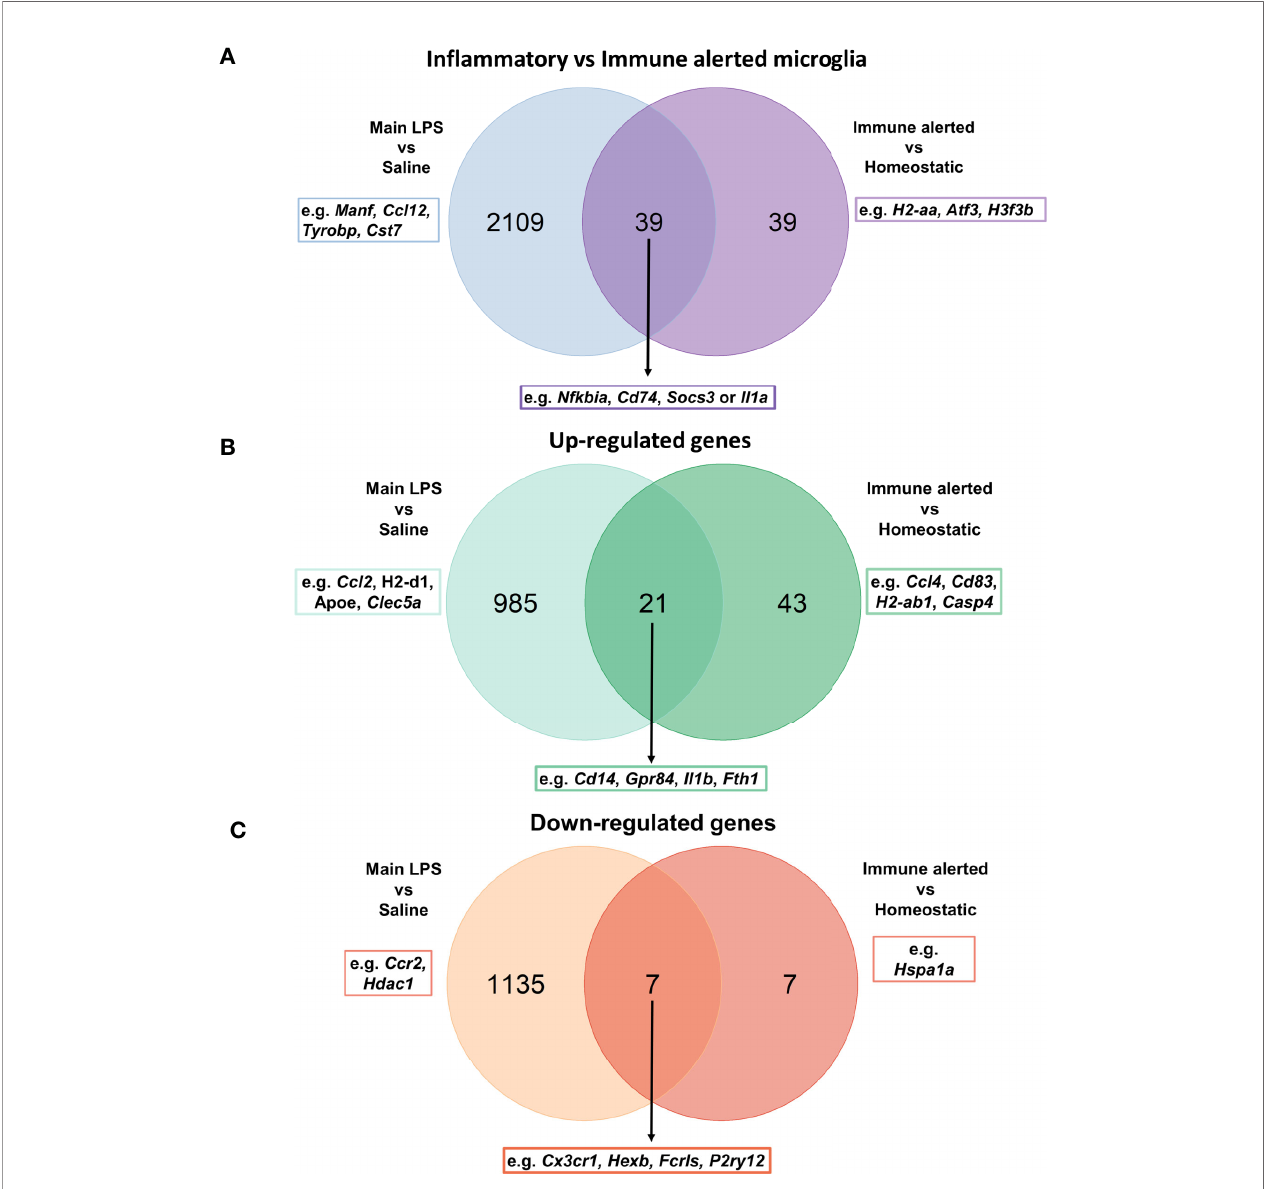
FIGURE 3 | Midbrain-enriched immune alerted microglia show transcriptional similarities to in fl ammation-associated microglia. (A – C) Venn diagrams showing the comparison between 78 differentially expressed genes across midbrain/striatum microglia subsets and 2,148 genes characterizing in fl ammation-associated microglia